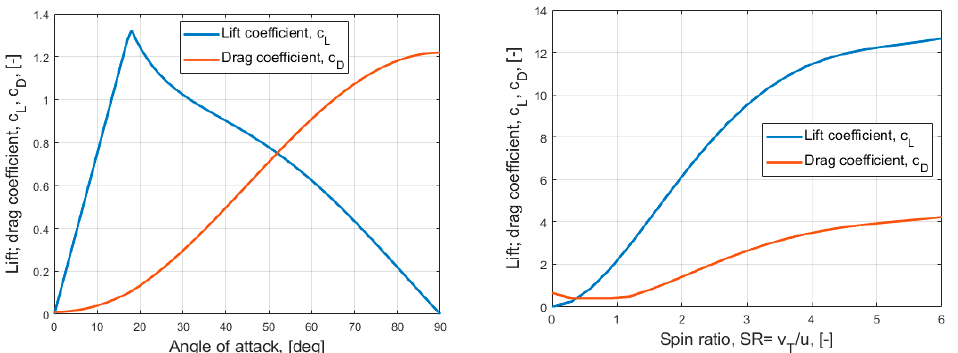
Figure 8. Lift and drag coefficient for a wing sail ( left ) and a Flettner rotor ( right ).